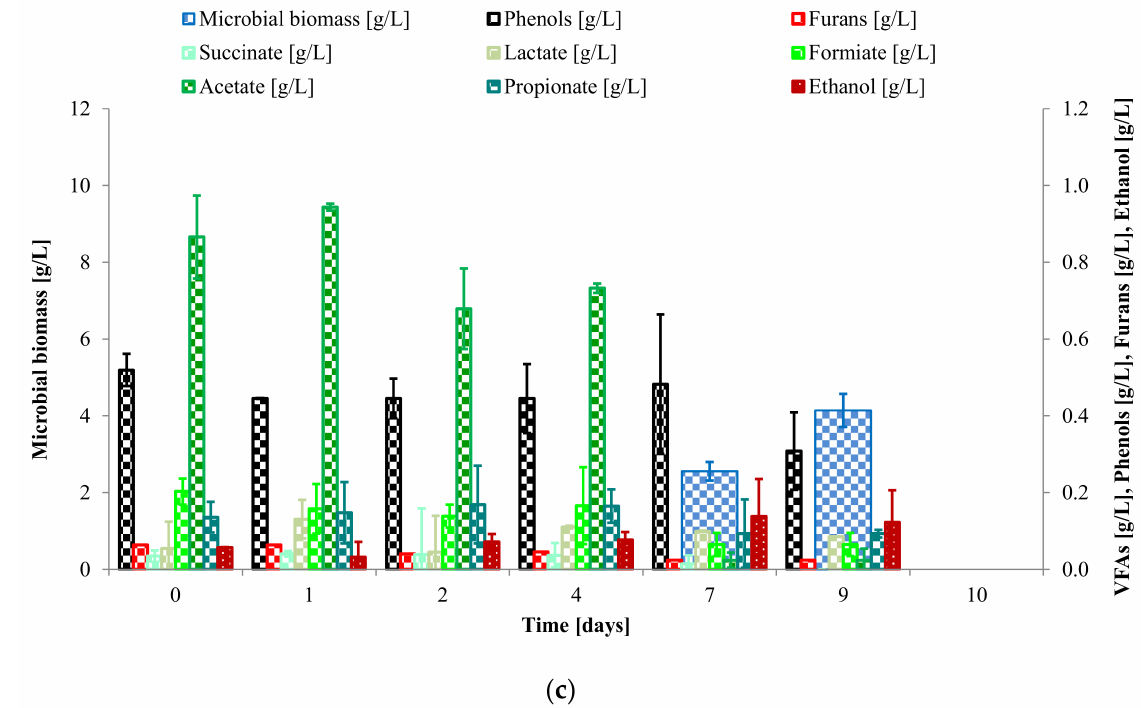
Figure 4. ( a ) Profiles of microbial biomass (g/L), VFAs, Phenols and Furans concentration (g/L) in Arundo donax hydrolysate (ADH) inoculated by C. saccharophilum . ( b ) Profiles of microbial biomass (g/L), VFAs, Phenols and Furans concentration (g/L) in Arundo donax hydrolysate (ADH) inoculated by L. starkeyi . ( c ) Profiles of microbial biomass (g/L), VFAs, Phenols and Furans concentration (g/L) in Arundo donax hydrolysate (ADH) inoculated by C. saccharophilum and L. starkeyi